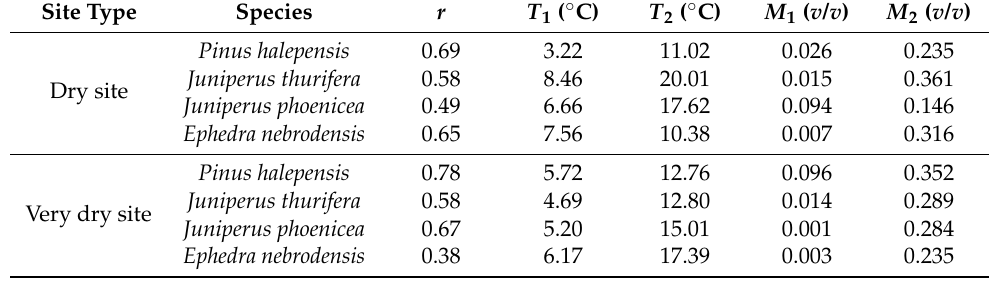
Table 3. The Pearson correlation coefficients ( r ) that were calculated between the mean series of the observed and simulated ring width indices for the calibration period (1960-2019). The Pearson correlation values ( r ) were always significant at the 0.05 level and are presented. The statistics of the Bayesian estimation of the growth response parameters ( T 1 , T 2 , M 1 , and M 2 for minimum and optimal temperature and soil moisture values, respectively) are also shown. See Table S2 for the cross-validated subperiods.